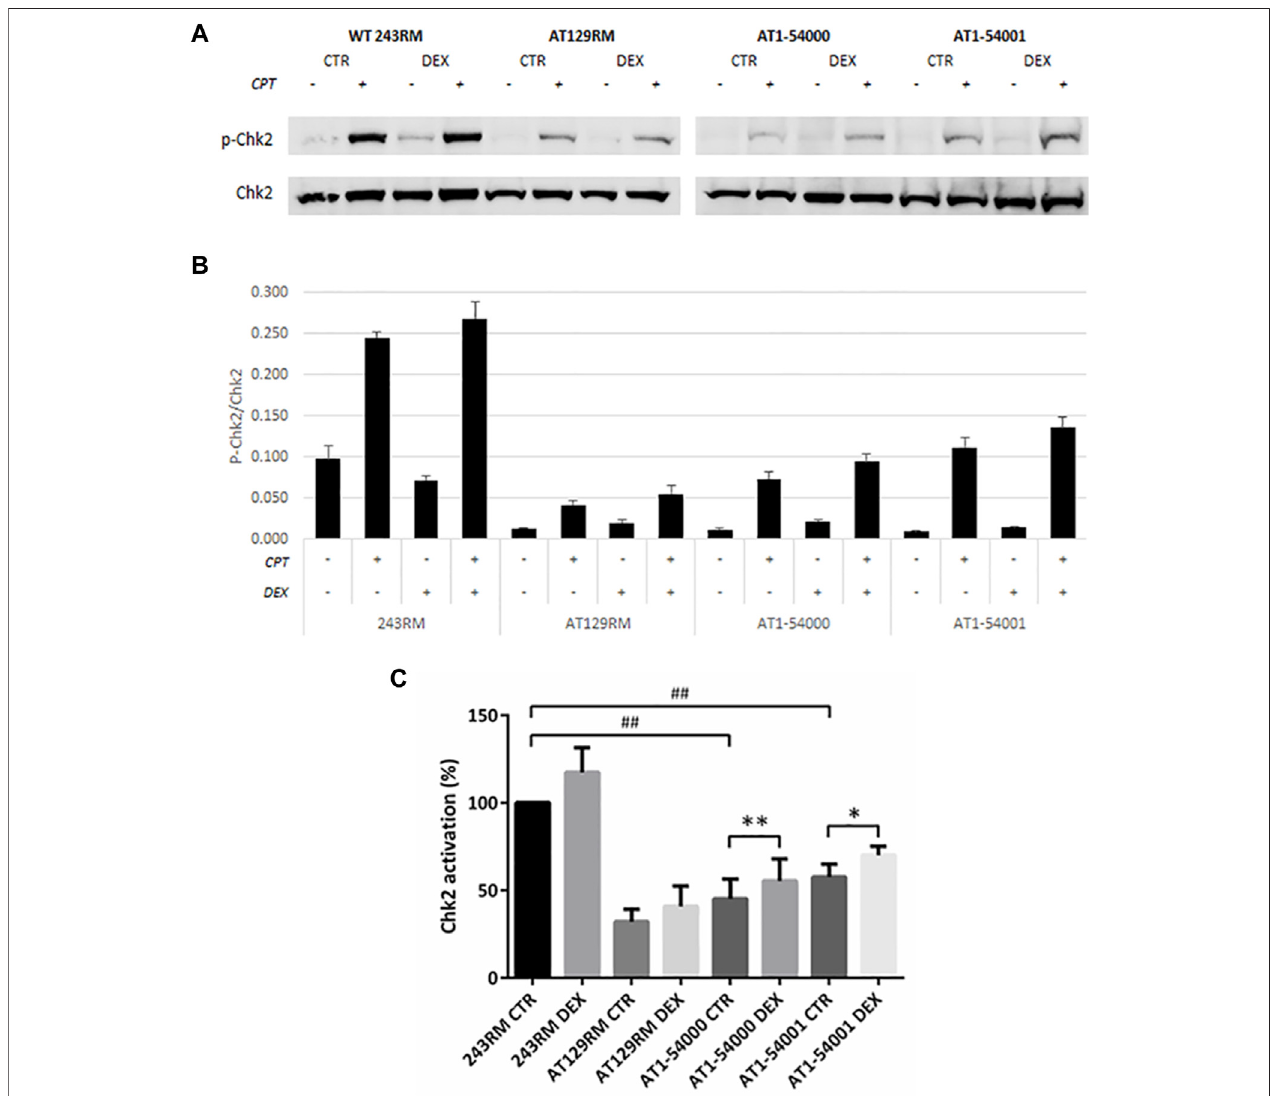
FIGURE 5 | Chk2 activation in LCL extracts. The activation status of Chk2 has been investigated in WT and AT cells, treated or not with DEX, and with or without CPT treatment. (A) Western blot analysis of p -CHK2 (Thr68) and total Chk2 protein in WT (243RM), classical AT (AT129RM), AT1-54000 and AT1-54001 protein extracts. (B) Quanti fi cation of the relative amounts of p -Chk2/Chk2 in the cell extracts of WT and ATcells shown in A. Blots shown are representative and values are the means and SEM of four independent experiments. (C) Quanti fi cation of Chk2 activation in each cell line, treated or not with DEX. Quanti fi cation has been obtained by subtracting the p -Chk2/Chk2 level found in the samples untreated with CPT from the respective sample treated with CPT. Values have been then expressed as percentage with respect to the WT control assumed as 100%. Signi fi cance has been calculated by using the non-parametric Mann-Whitney test for unpaired samples (## two-tailed p values < 0.005) or by using the Wilcoxon signed rand test for paired samples treated or not with DEX (two-tailed p -values * < 0.05, ** <